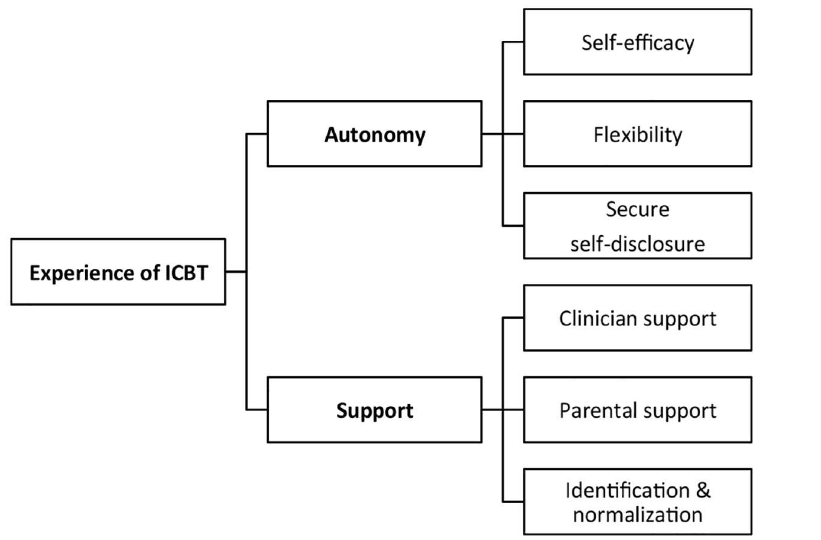
Fig 2. A hierarchical model of adolescents´ experiences of